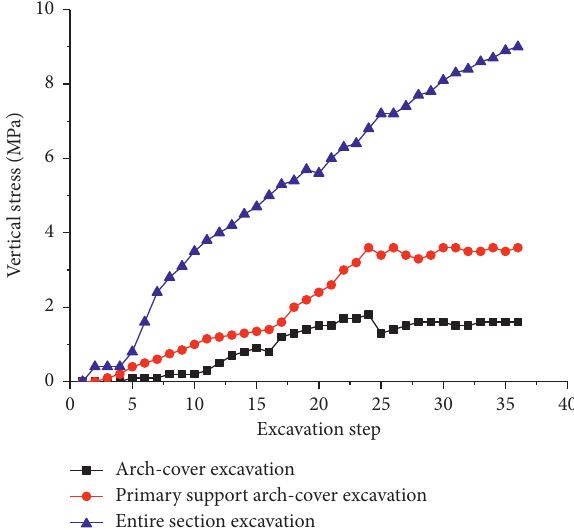
Figure 15: Vertical stress curves with sustainable excavation.